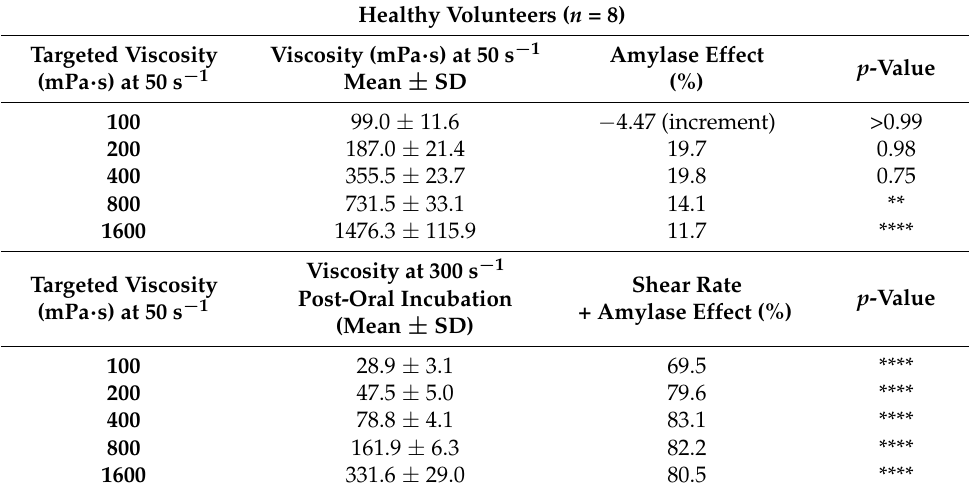
Table 8. Shear viscosity decrease caused by both swallowing factors (salivary amylase in the oral phase and shear thinning in the pharyngeal phase) in healthy